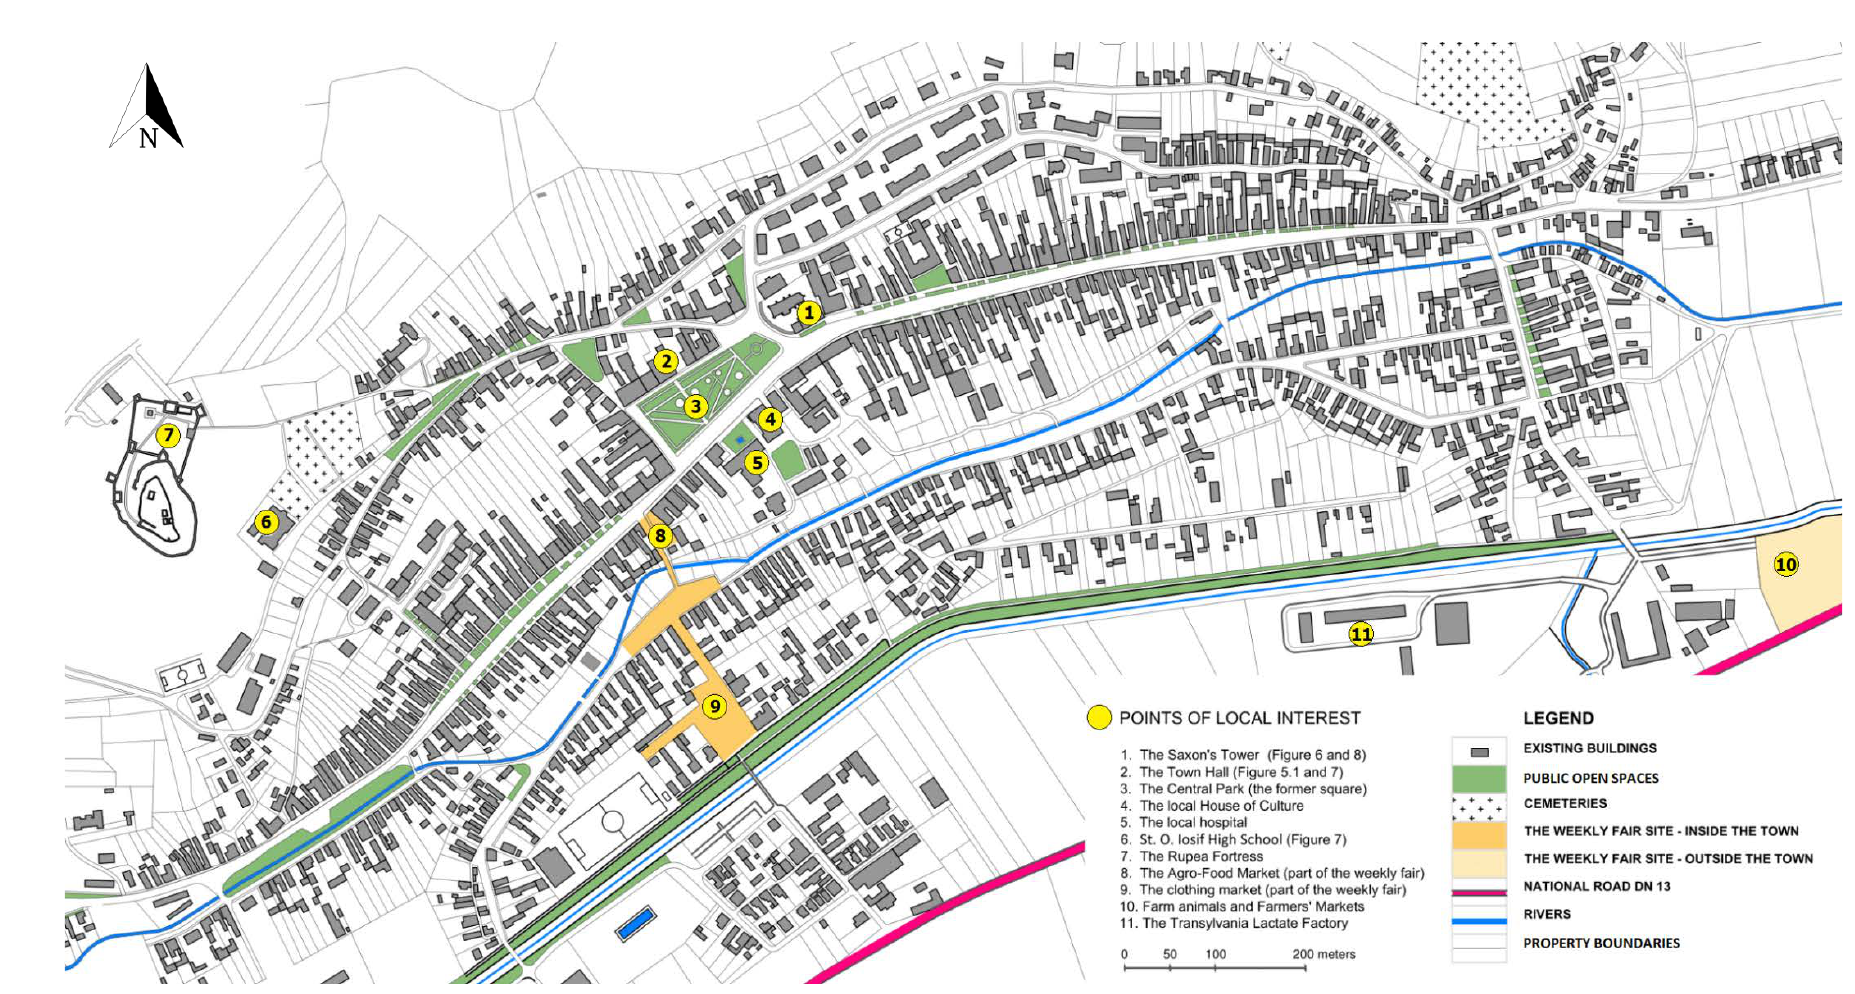
Figure 12: Rupea town street network and urban